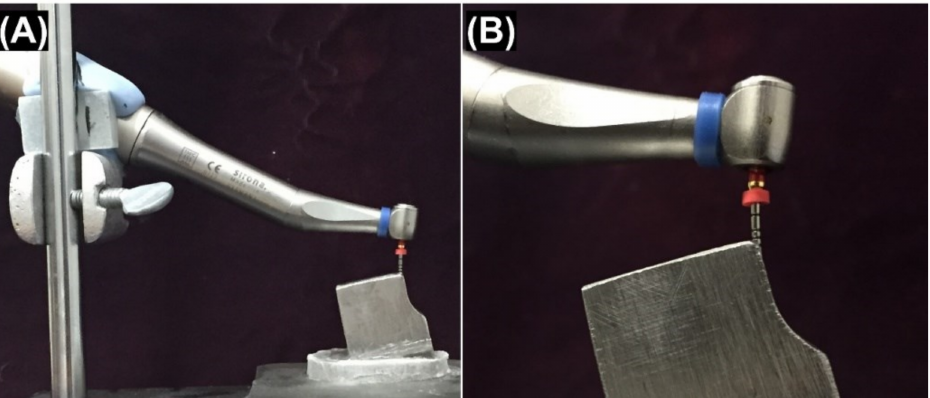
Figure 1. An illustration of the experimental setting involving a NiTi rotary file and the testing